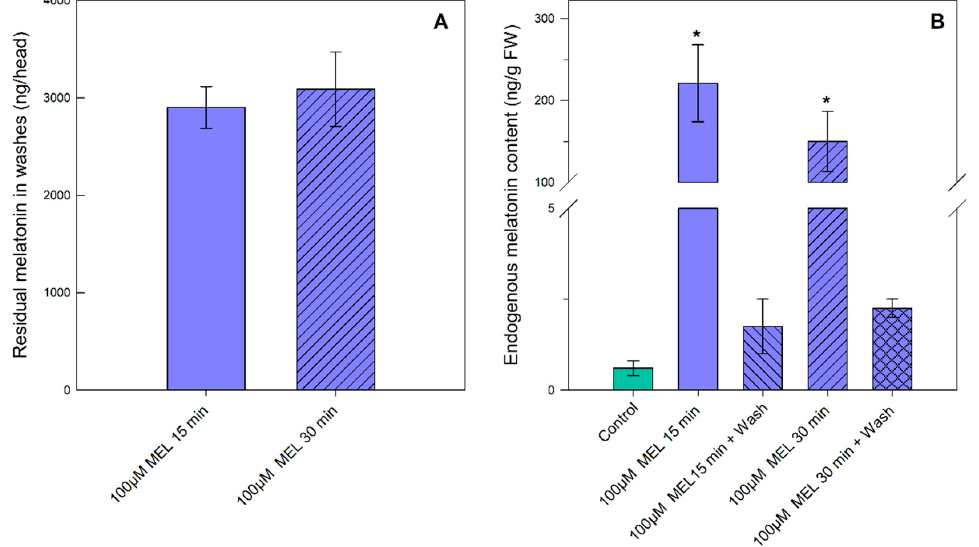
Figure 6. Melatonin quantification by LC-FLUO: ( A ) in the wash solutions of melatonin-treated broccoli heads; ( B ) endogenous melatonin content of diverse broccoli treated samples. Each bar represents the mean value ± standard error ( n = 3) obtained for each concentration used. Asterisks indicate significant differences between washed and unwashed broccoli heads based on a Tukey HSD test with a significance level of p < 0.05.